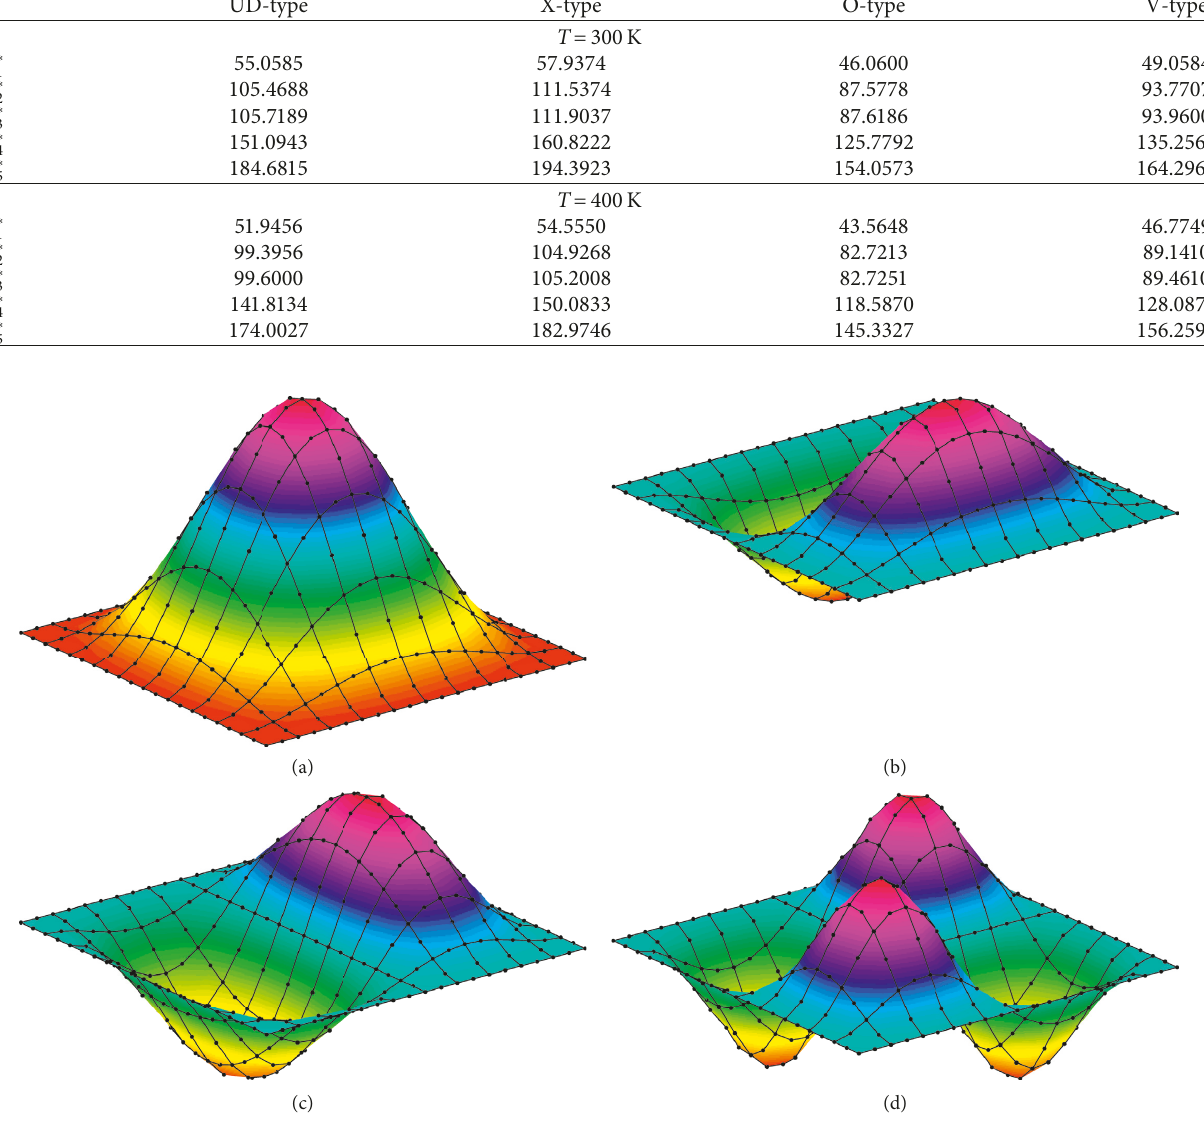
Figure 4: First four vibration mode shapes of fully clamped SPH: (a) mode 1; (b) mode 2; (c) mode 3; (d) mode